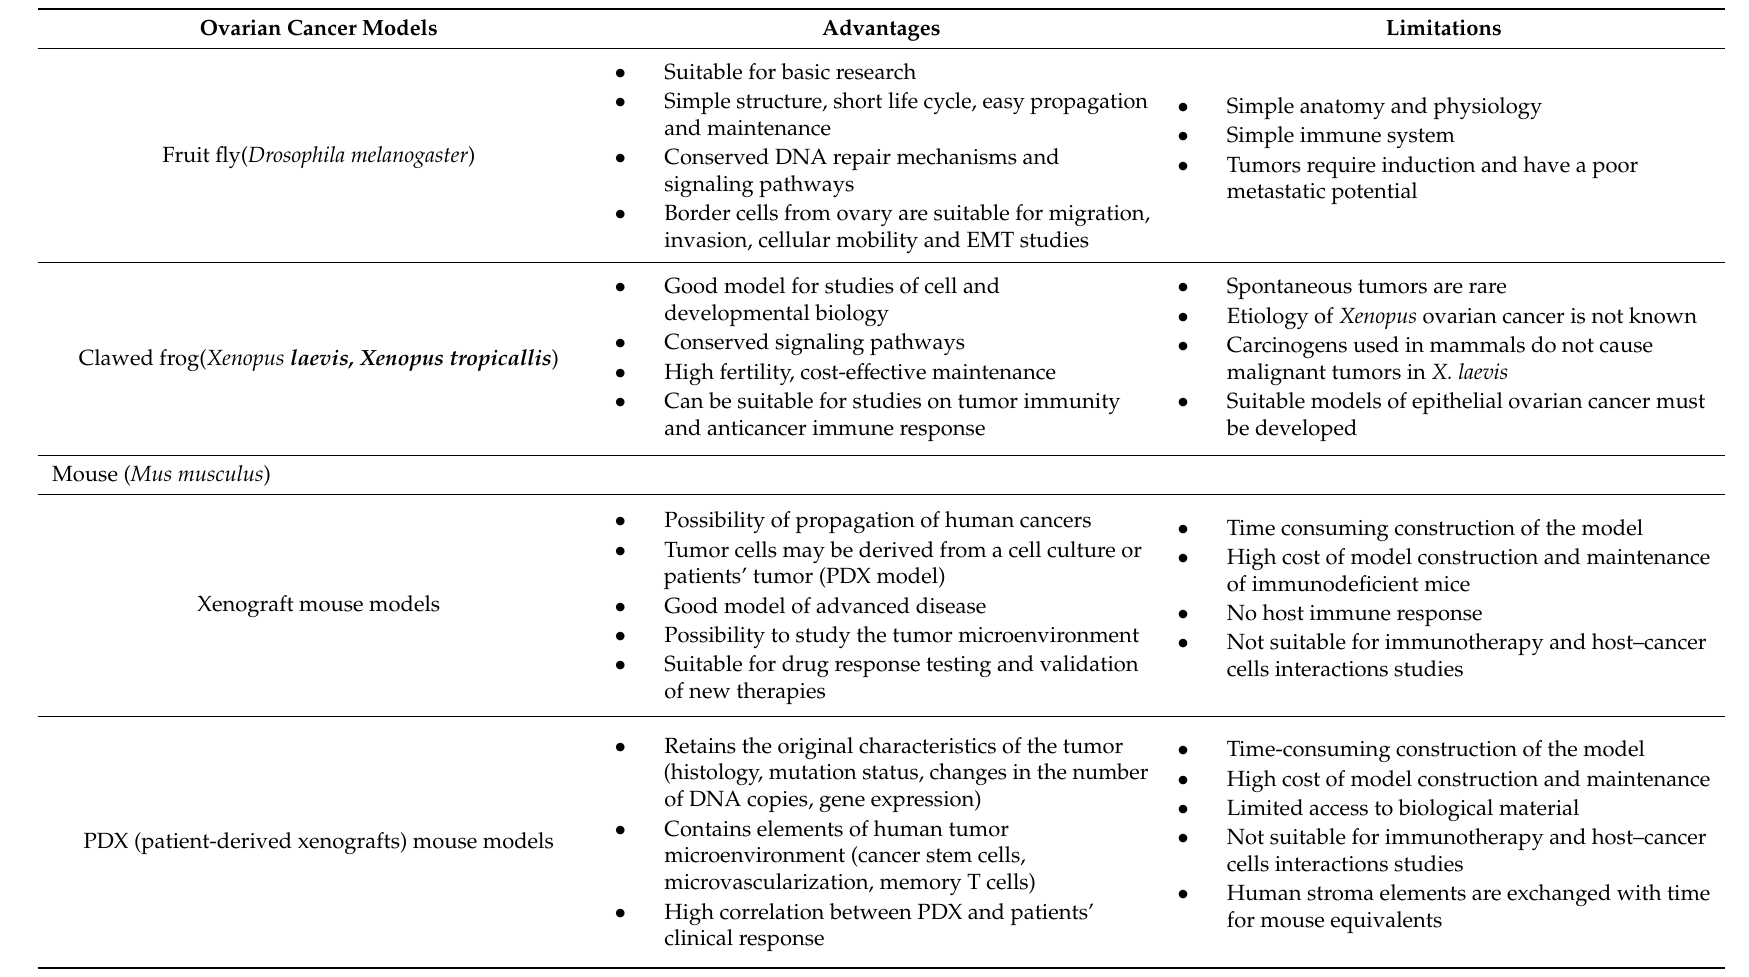
Table 4. Advantages and limitations of ovarian cancer models. EMT—epithelial-to- mesenchymal